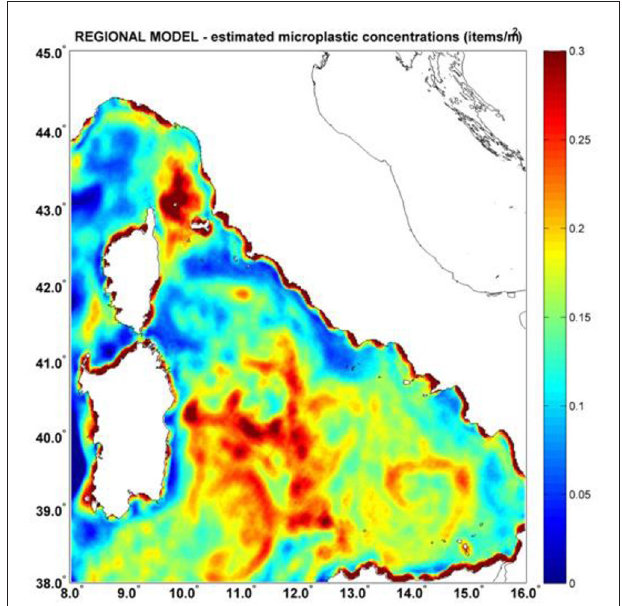
FIGURE 8 | Modeling marine litter distribution. Estimated concentrations of microplastics (items/m 2 ) in the period September-October 2014; map produced using the Matlab Release 14 software (https://www.mathworks.